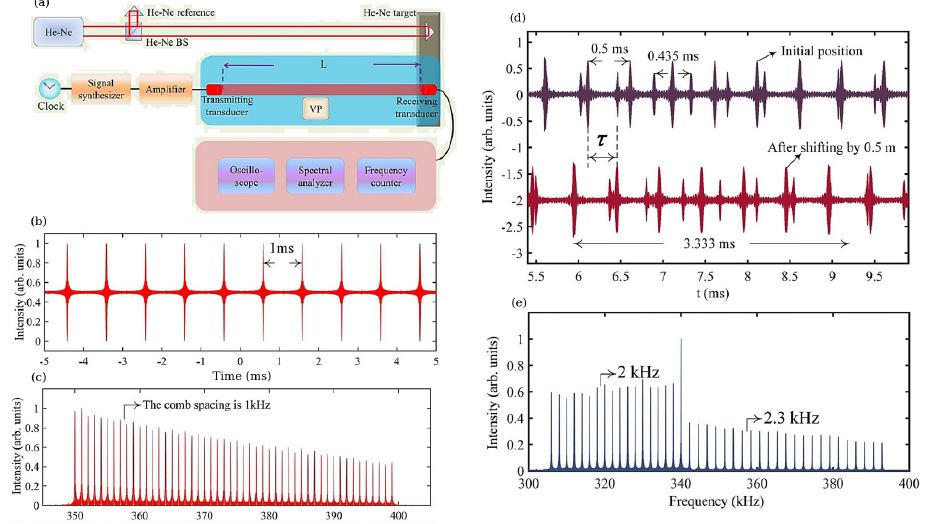
Figure 3. ( a ) Schematic of the experimental setup employed to generate an AFC using a Rb-clock- stabilised electronic FC and a set of piezo-electric transmitting transducers and subsequently exploit the resulting AFC for measuring the distance in an underwater environment (VP—sound velocity profiler; BS—beam splitter). ( b ) Acoustic pulse train in the time domain in the 350–399 kHz frequency range and ( c ) the AFC spectrum corresponding to it. ( d ) Waveforms detected by the receiving transducer in the time domain. The upper waveform was detected at the initial position and the lower one obtained after moving the receiving transducer by 0.5m. ( e ) Spectrum of the waveform in panel ( d ) showing two different repetition frequencies. Reproduced from [5] with permission of John Wiley and